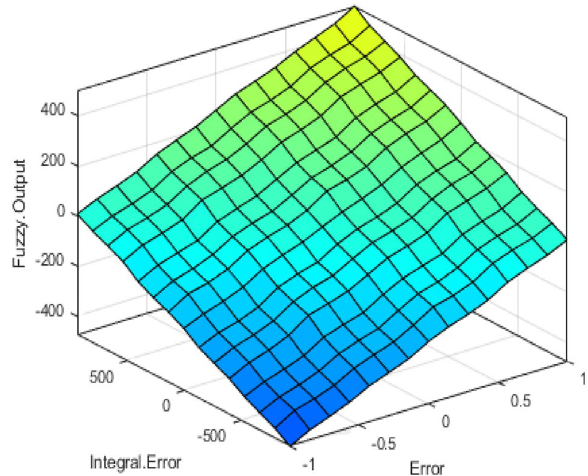
Fig. 12 Results obtained from fuzzy logic (Surface view for error, integral error, and